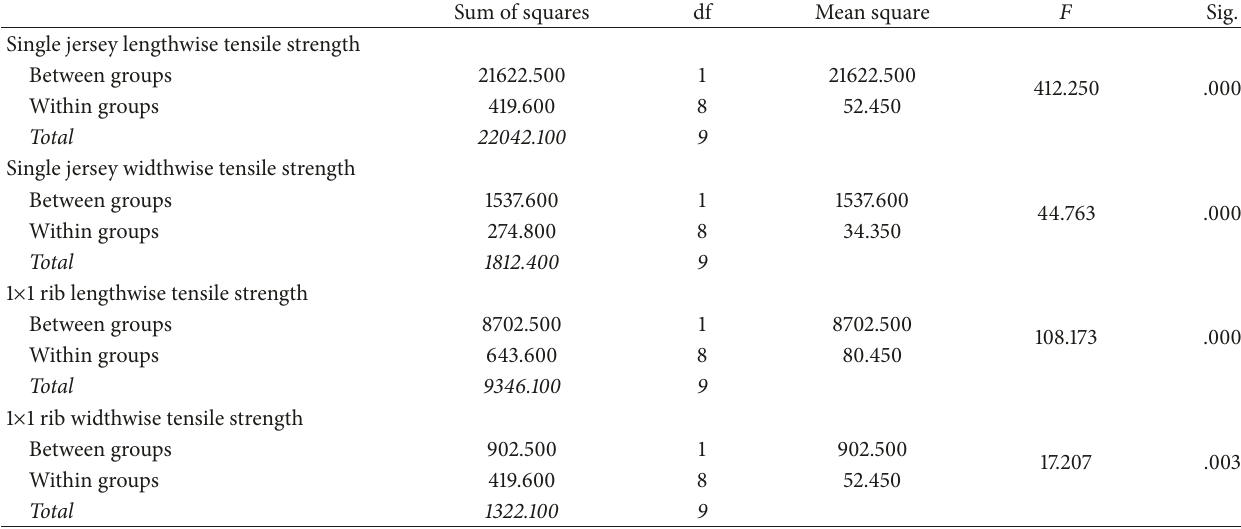
Table 9: Analysis of variance for tensile strength of single jersey and 1 × 1 rib knitted fabrics made from 100% cotton and cotton/Lycra (95/5%). Sum of squares df Mean square 𝐹 Sig.